Question: Draft a figure caption describing what is shown.
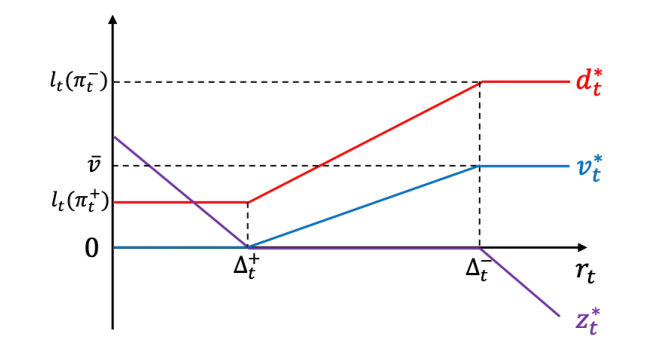
Answer: Procrastination threshold policy for δt < yt < τt.